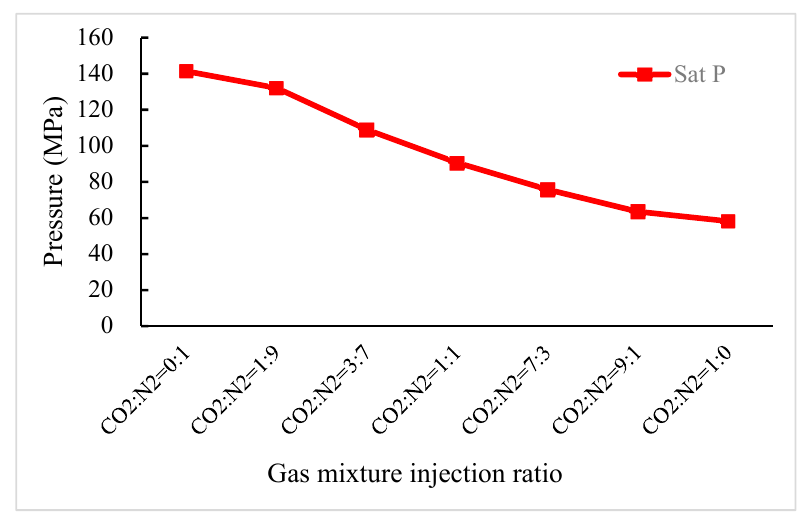
Figure 6. Asphaltene deposition pressure change with different injection ratios of a gas mixture at 161.8 °C in a buried-hill reservoir.